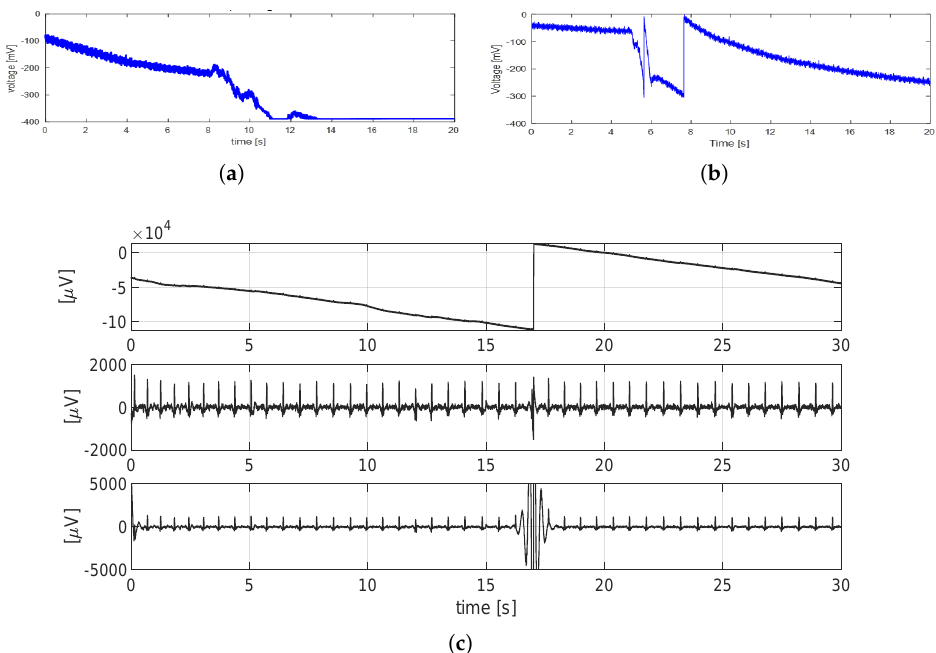
Figure 3. ( a ) Example of a channel acquired without reset. ( b ) Example of a channel acquired with reset. ( c ) Influence of the reset artifact on the signal. The plot above shows the acquired signal; at t = 17 there is a step due to the reset. The signal after filtering if the step is removed is shown in the middle. The plot on the bottom shows the filtered signal if the step is not removed.